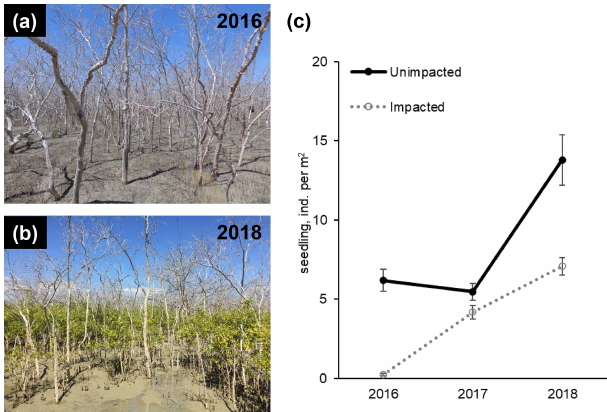
Figure 2. Recovery of mangrove vegetation at the impacted site during a 2-year period from 2016 to 2018 ( a and b ; approx. 8 and 32 months, respectively, after the dieback event). Seedling and sampling densities of mangrove species (mostly, A. marina ) signif- icantly increased in the impacted site ( c ; Table